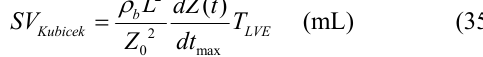
Fig. 5. ECG, ∆Z(t) and dZ/dt waveforms from a human subject. For ∆Z(t) note Nyboer’s maximum down-slope backward extrapolation to find ∆Z max . Also note Kubicek’s maximal systolic up-slope forward extrapolation of ∆Z(t). For dZ/dt, point B = aortic valve opening; point X = aortic valve closure; Y = pulmonic valve closure; O = rapid ventricular filling wave; Q–B interval = pre-ejection period (s); B–C interval = time- to-peak (TTP, s) of dZ/dt max ; B–X interval; left ventricular ejection time (T LVE , s). dZ/dt waveform to right shows the square wave integration (shaded area), dZ/dt max remaining constant over the ejection interval, which represents outflow compensation. Modified from reference